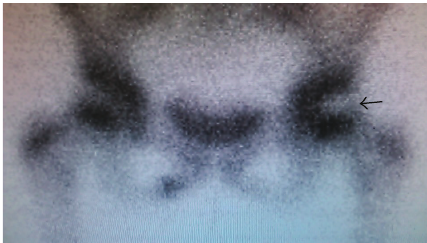
Figure 8: Plain radiograph of the hip joints 7 years after the initial visit. Good remodeling of the necrotic area at the left femoral capital epiphysis was